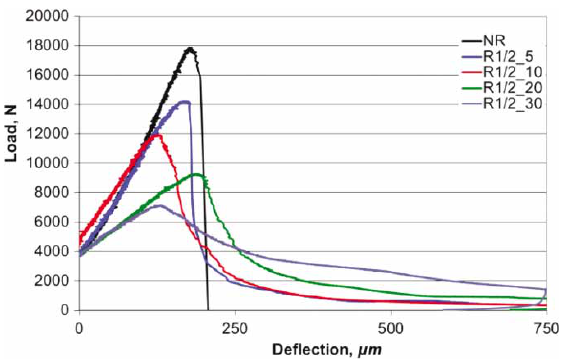
Fig. 4. The function of stress and CMOD when 2/3 fraction is